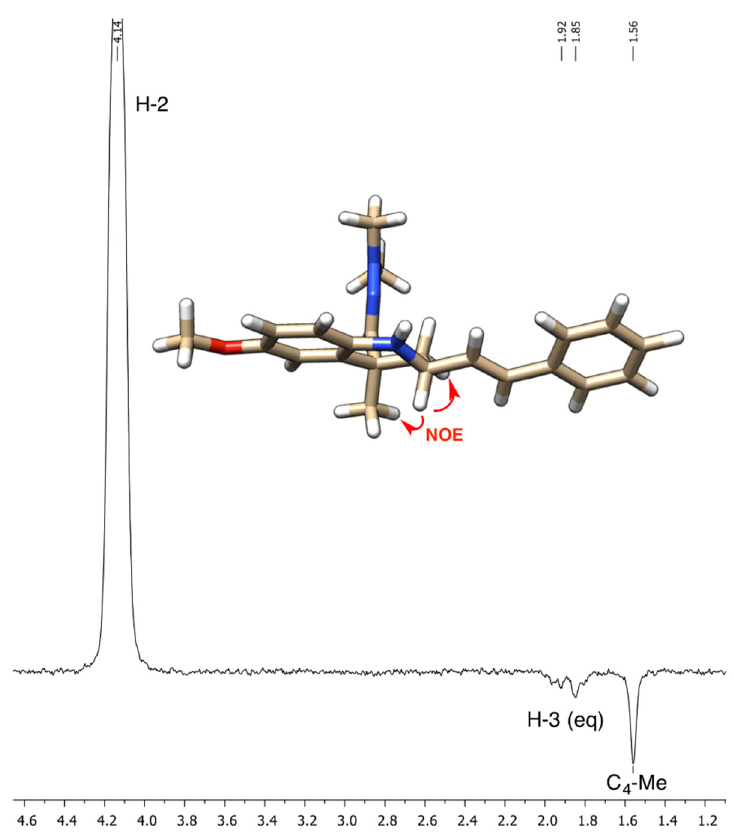
Figure 2. NOE assignment of the relative configuration of compound 5.